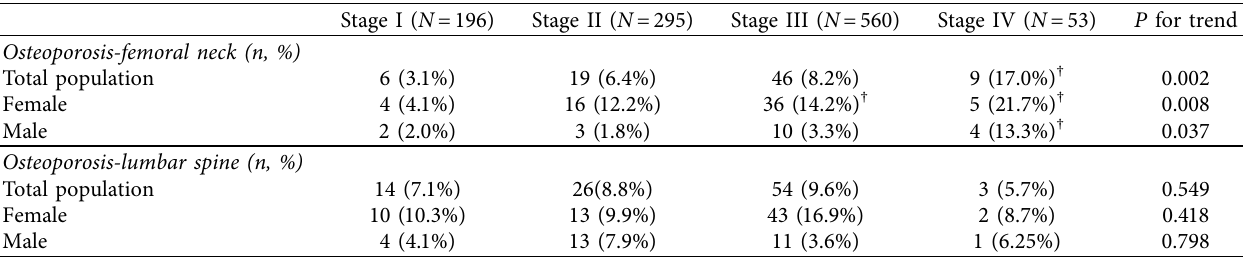
Table 4: Prevalence of osteoporosis in the at-risk population according to the severity of